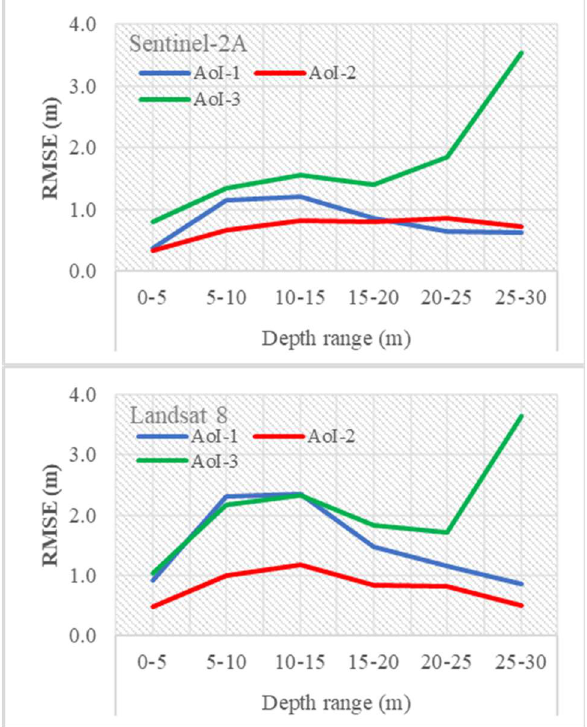
Figure 4. The RMSE values for each 5 m range of